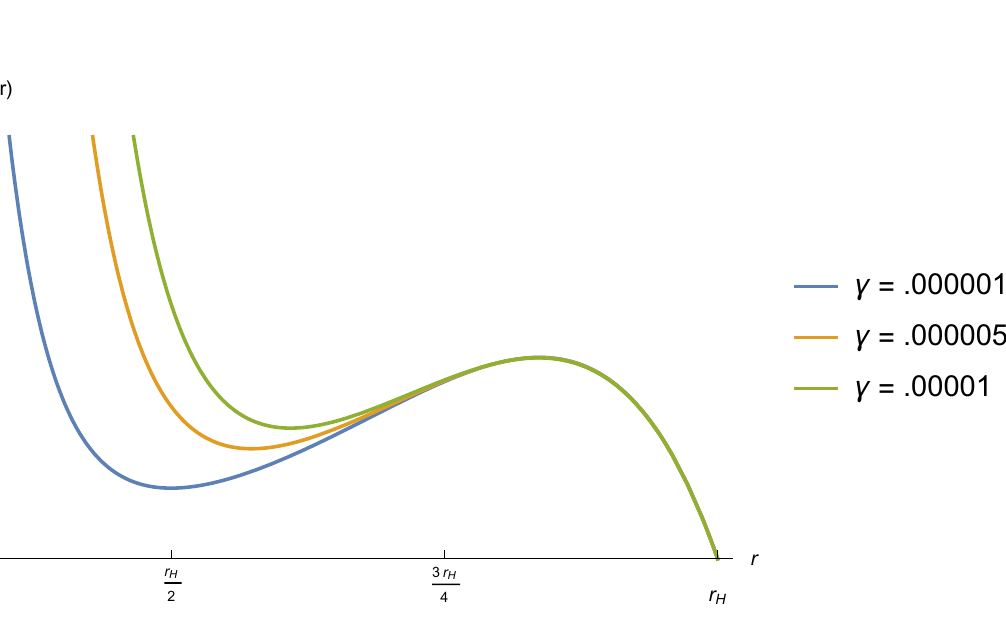
Figure 10. The square V 2 ( r ) of the volume functional for the (cid:13) -corrected AdS-Schwarzschild geometry in the Weyl 4 theory, plotted for several values of (cid:13) (labeled). We have adjusted the range of the r -axis so that the extrema are more clearly visible.